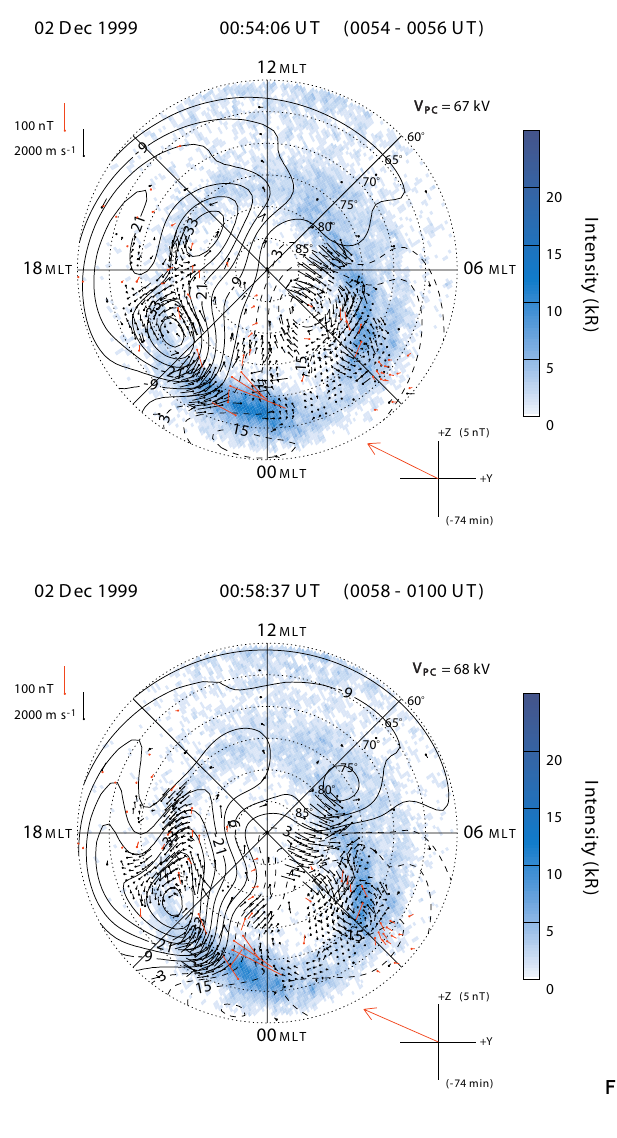
Fig. 7. Maps of the UV auroral lu- minosity projected onto a geomagnetic grid are shown spanning the same in- terval as in Fig. 6. SuperDARN Map- Potential streamlines and flow vectors are superposed. Magnetic data, shown in red, are horizontal magnetic pertur- bation vectors which have been rotated anti-clockwise through 90 ◦ to point in the direction of the E × B drift, as- suming they are due wholly to over- head Hall currents. Also indicated on the maps is the derived total transpolar voltage and the direction and magnitude (in the Y − Z plane) of the IMF, as in Fig. 6. The time indicated on each plot corresponds to the center time of the 32.5s integration interval of the UV im- age. The superposed SuperDARN and 2-min averaged magnetic vectors corre- spond to the interval shown in brackets, which encompasses the center time of Fig. 7c the UV